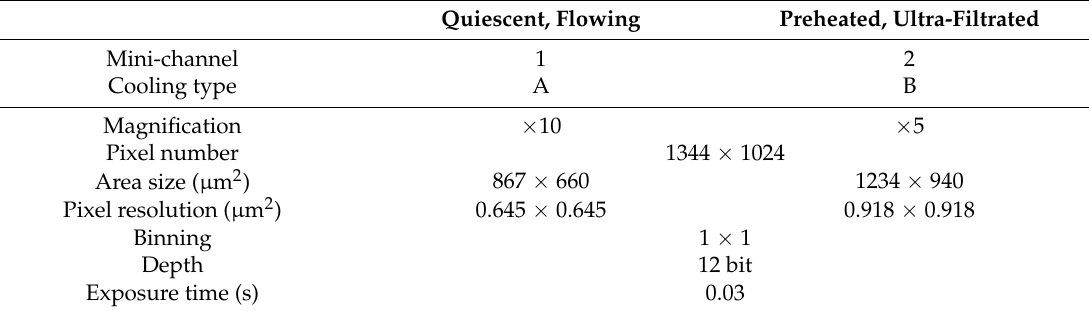
Table 1. Image-capturing condition.